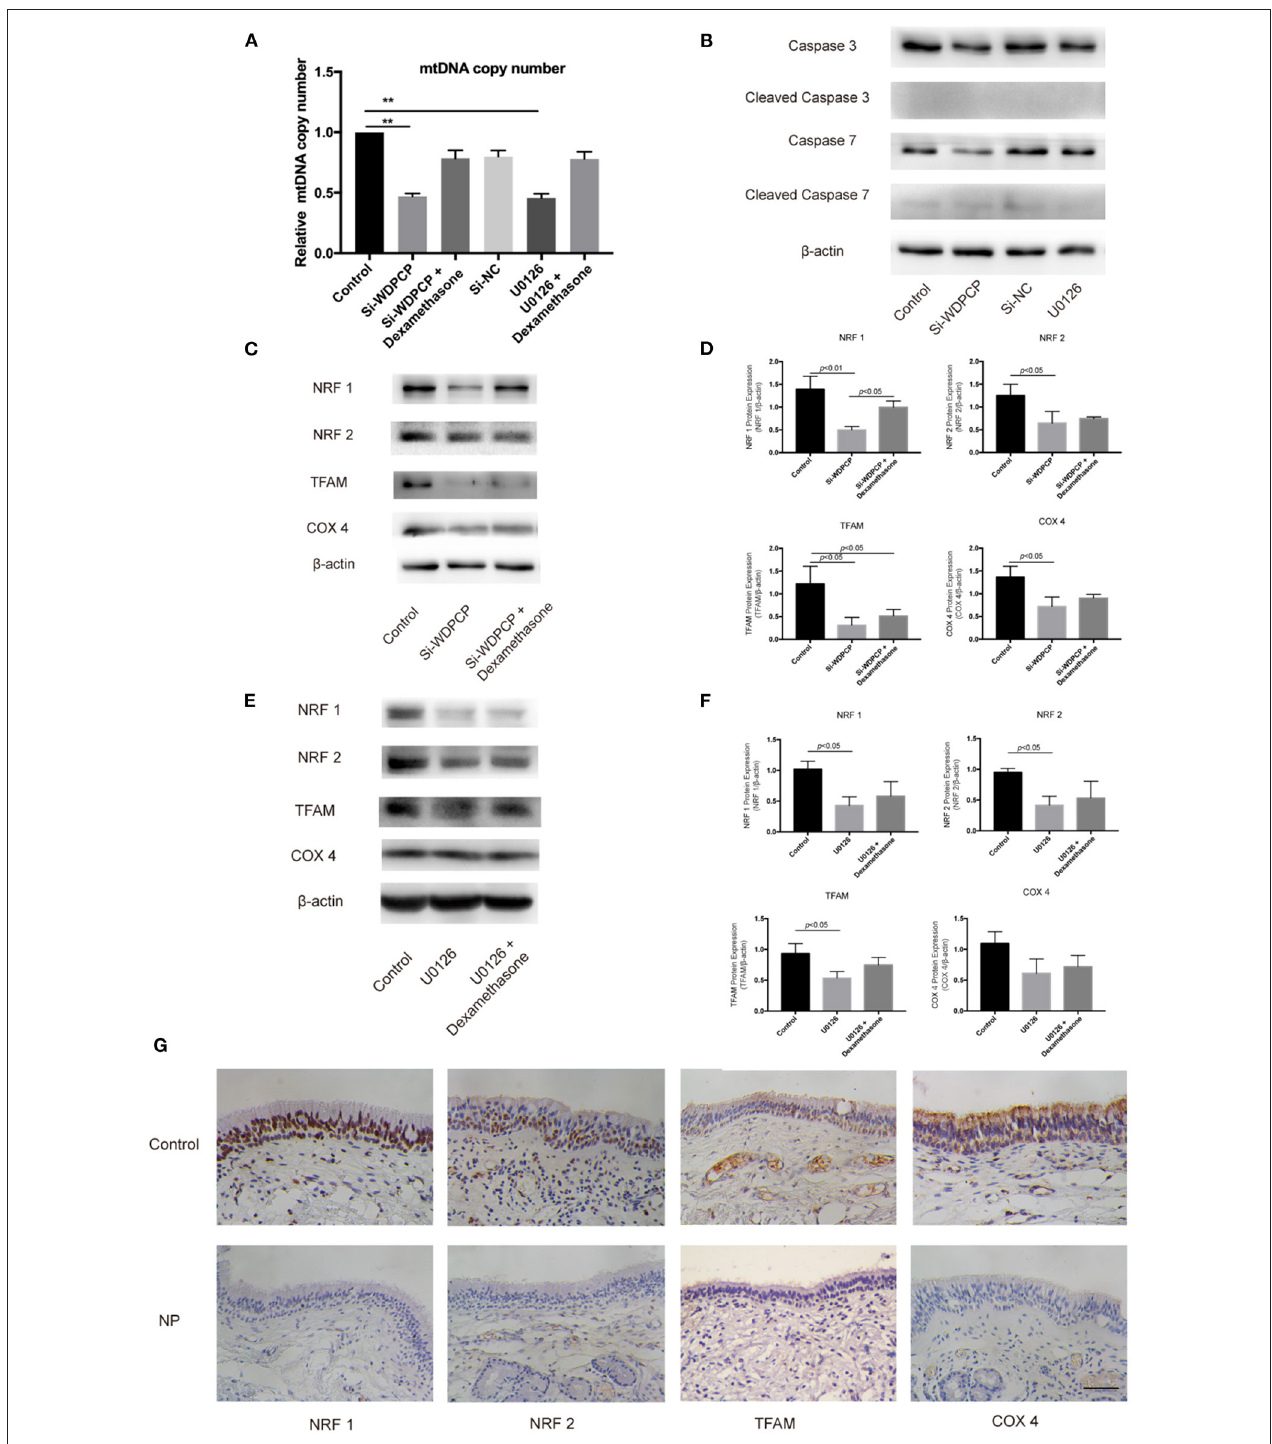
FIGURE 3 | WDPCP silencing or inhibition of the MAPK/ERK pathway could reduce mitochondrial biogenesis. (A) mtDNA copy number was decreased in Si-WDPCP HSECs and U0126-treated HSECs ( n = 3). (B) WDPCP silencing or the inhibition of the MAPK/ERK pathway did not activate mitochondrial apoptosis. (C,D) NRF1, NRF2, TFAM, and COX4 protein levels were reduced after WDPCP silencing in HSECs by western blot and densitometry analysis. The reduction of NRF1 could be recovered by dexamethasone ( n = 3). (E,F) NRF1, NRF2, and TFAM protein levels were reduced in U0126-treated HSECs ( n = 3). (G) Mitochondrial biogenesis markers NRF1, NRF2, TFAM, and COX4 had low expressions in the epithelium of nasal polyps by immunohistochemical staining. Scale bar: 50 µ m.